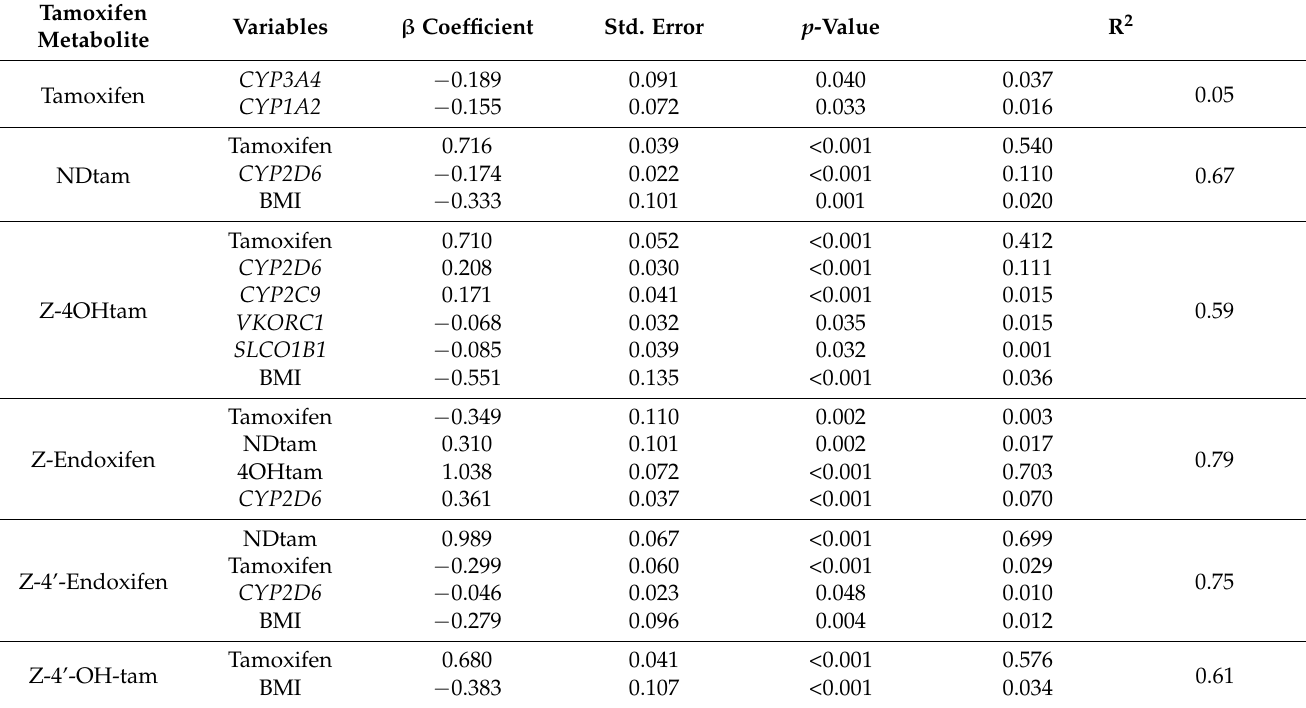
Table 4. Genetic and Clinical Factors Associated with Tamoxifen